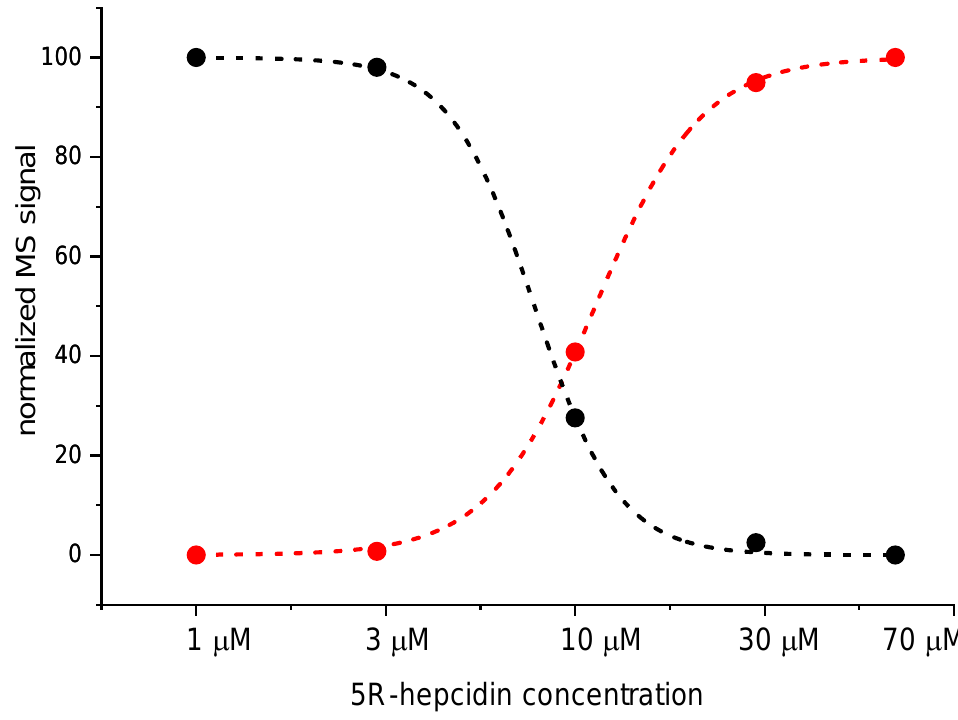
Figure 4. Integrated native MS signals of Cd 2 hepcidin-25 (black dots) and Cd 2 5R-hepcidin (red dots) obtained from the titration of 10 µ M Cd 2 hepcidin-25 with 5R-hepcidin. The lines represent fits for the competition constant for the reaction Cd 2 hepcidin-25 + 5R-hepcidin = hepcidin-25 + Cd 2 5R-hepcidin. The MS spectra indicated only low amounts of other metallated species (see Figure S3).